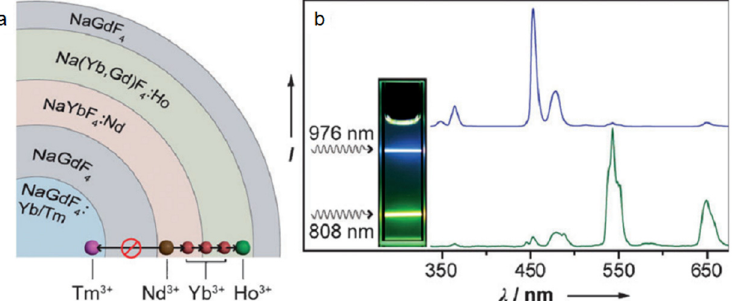
Figure 6. ( a ) Schematic design of tuning the Nd-sensitized upconversion process through nanostructural engineering. ( b ) Emisssion spectra of the multishelled nanoparticles under excitation at 808 and 976 nm, respectively. Inset: digital camera photograph of corresponding solution sample. Reproduced with permission from [27]. Copyright John Wiley & Sons, 2013.